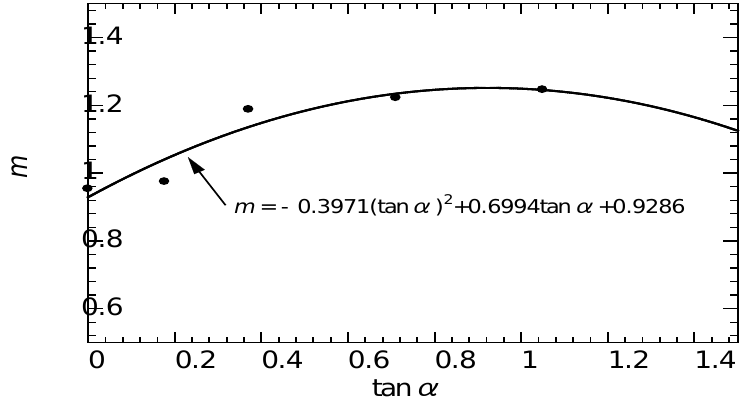
Figure 11: Variation of m against tan α for smooth tube and wire-coil inserted tubes.